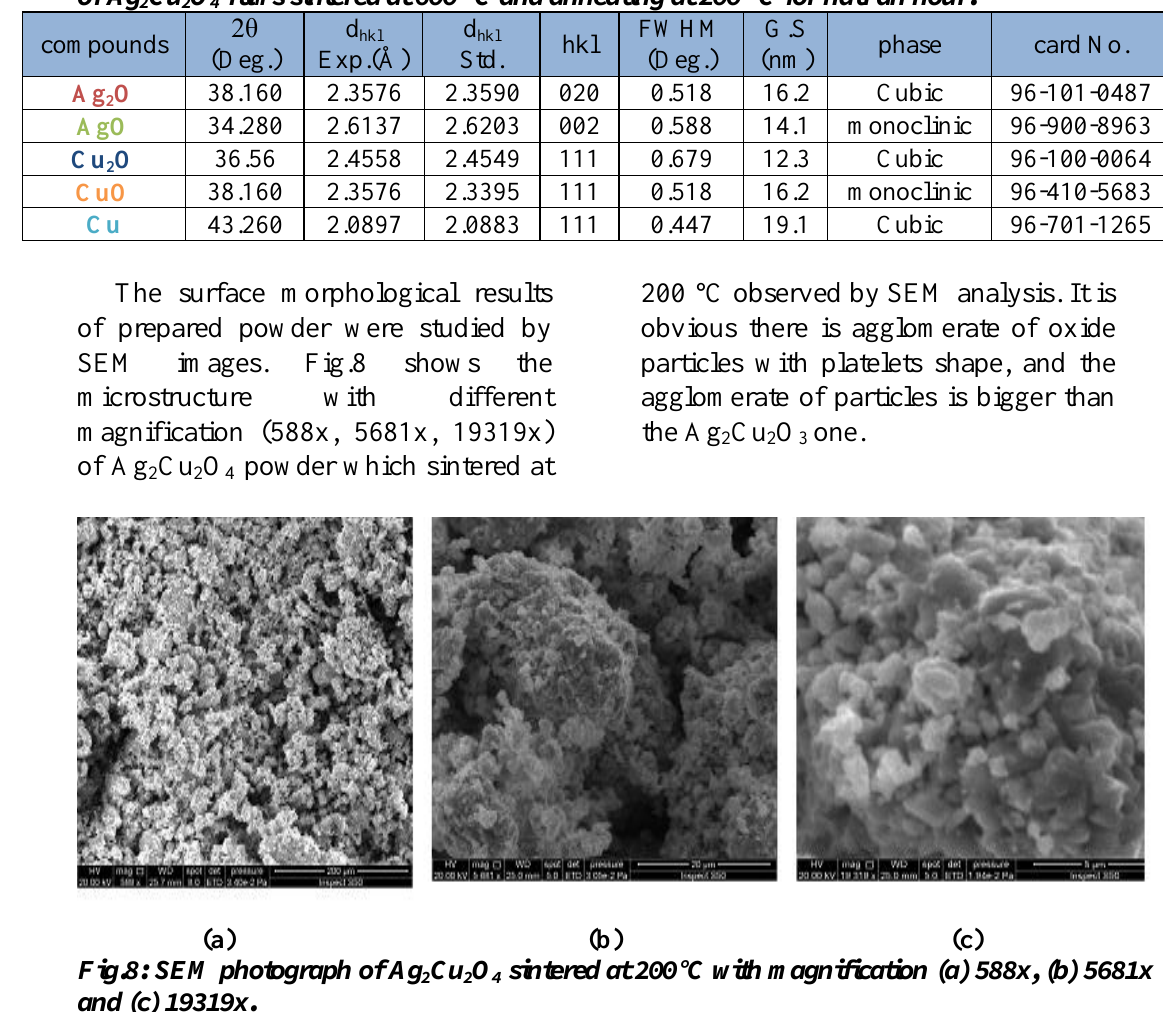
Fig.8: SEM photograph of Ag and (c)